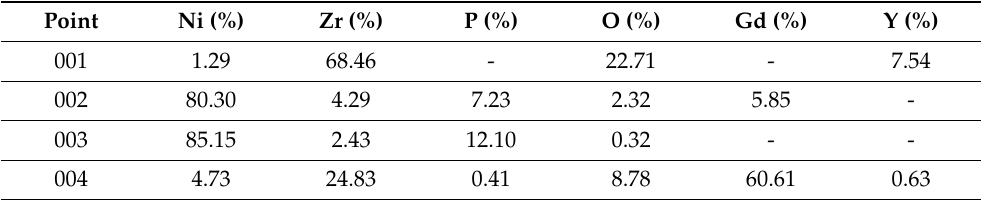
Figure 6. The analyzed area with selected analysis points and 1–4-point analysis. Table 2. Results of the point analysis performed by the EDS method (atom %).